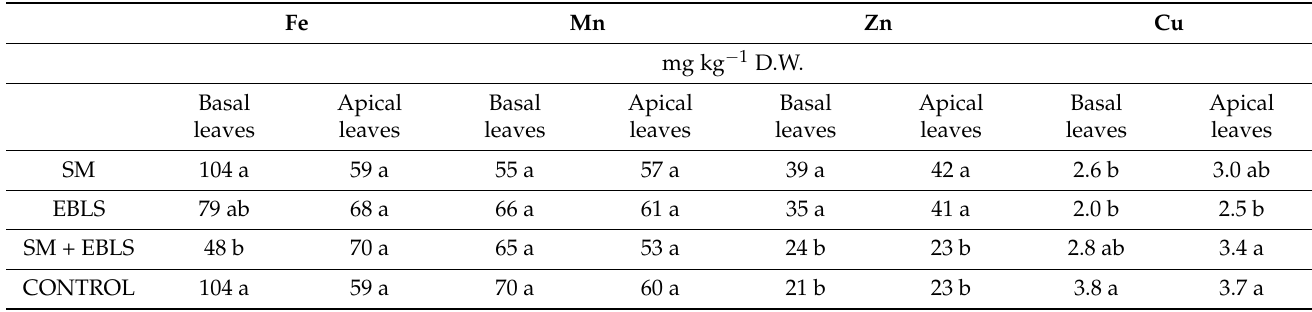
Table 5. Leaf micronutrient concentrations of the olive plants among the